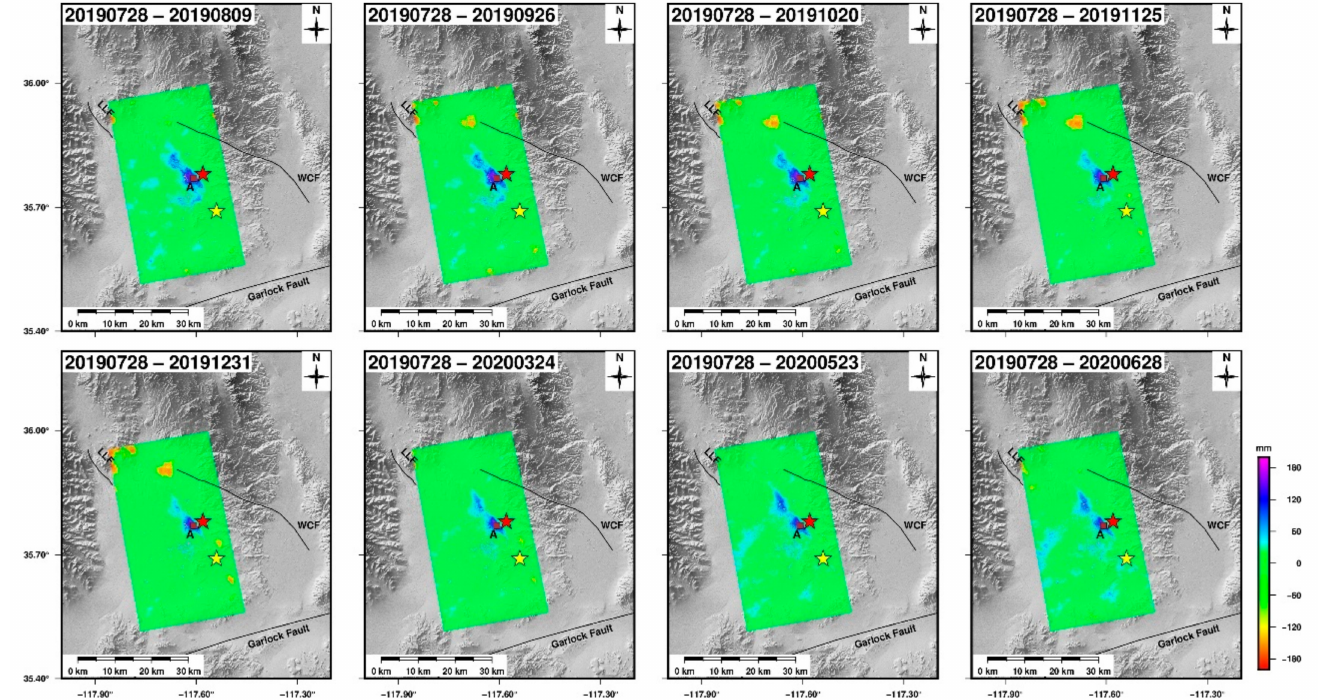
Figure 4. Partial post-seismic time-series deformation in line of sight (LOS). Red and yellow stars represent mainshock and foreshock,